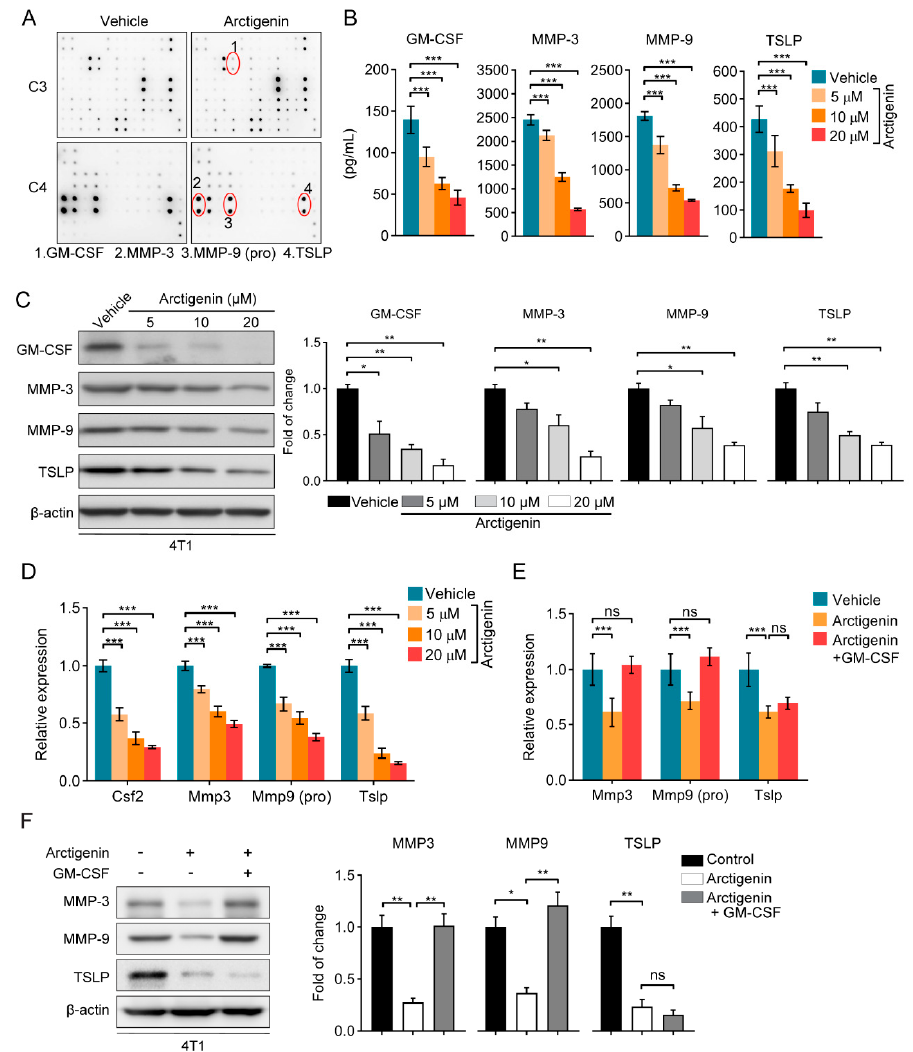
Figure 2. Arctigenin suppresses GM-CSF and TSLP expression in breast cancer cells. ( A ) Mouse cytokine array analysis of conditioned medium from 4T1 cells treated with arctigenin (10 µ M) or vehicle. ( B ) Quantification of GM-CSF, MMP-3, MMP-9 and TSLP in conditioned medium from 4T1 cells in the presence or absence of indicated concentrations of arctigenin. ( C ) Western blot analysis of GM-CSF, MMP-3, MMP-9 and TSLP in 4T1 cells treated with arctigenin at indicated concentration. ( D ) qRT-PCR analysis of the expressions of GM-CSF, MMP-3, MMP-9 (pro) and TSLP in 4T1 cells treated with indicated concentrations of arctigenin. ( E , F ) qRT-PCR analysis of the expressions of MMP-3, MMP-9 (pro) and TSLP ( E ) and Western blot analysis of the expressions of MMP-3, MMP-9 and TSLP ( F ) in 4T1 cells treated with recombinant mouse GM-CSF (1 ng/mL) in the presence of arctigenin (20 μ M). For ( B – F ), values represent mean ± SEM of three independent experiments. Statistically significant di ff erences are indicated: * p < 0.05, ** p < 0.01, *** p < 0.001, ns, not significant, p > 0.05 (One-way